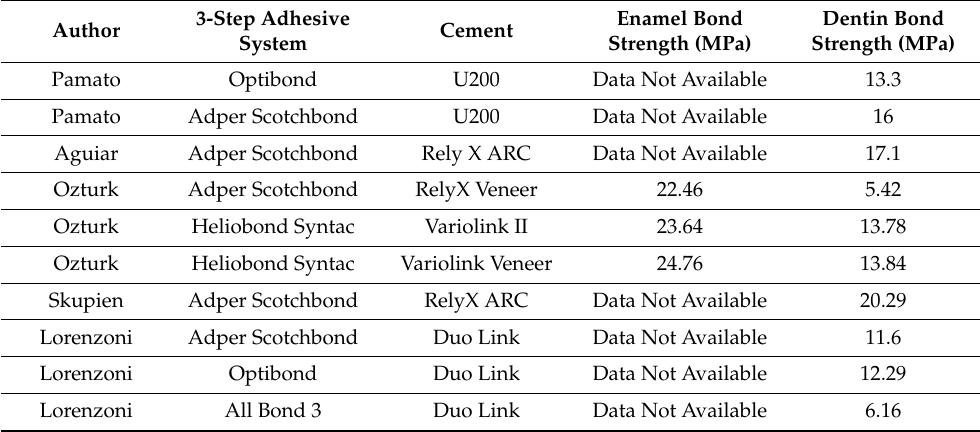
Table 1. Risk bias factor.